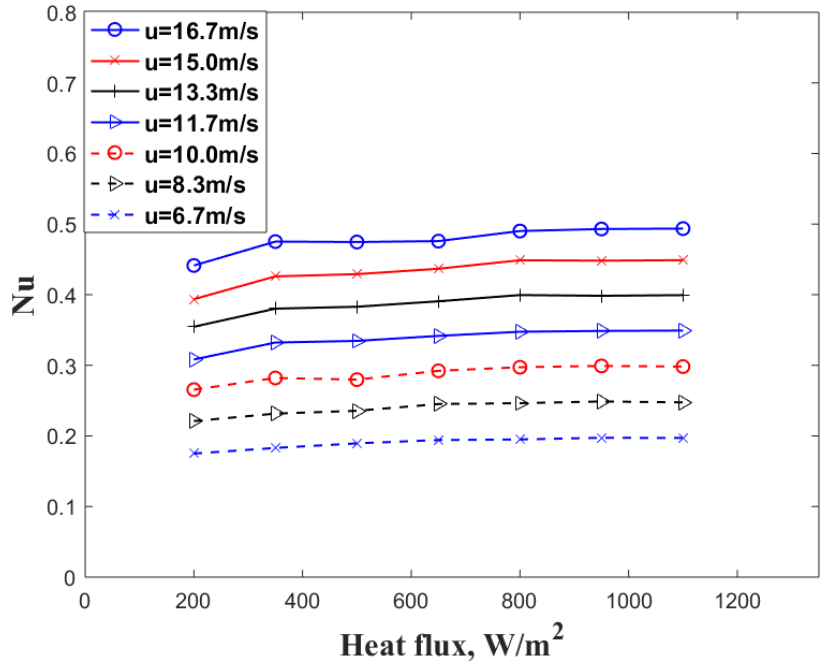
Figure 9. The variation of the Nusselt number with the HFV at various volume flow rates of air and inlet temperature of 25 °C.